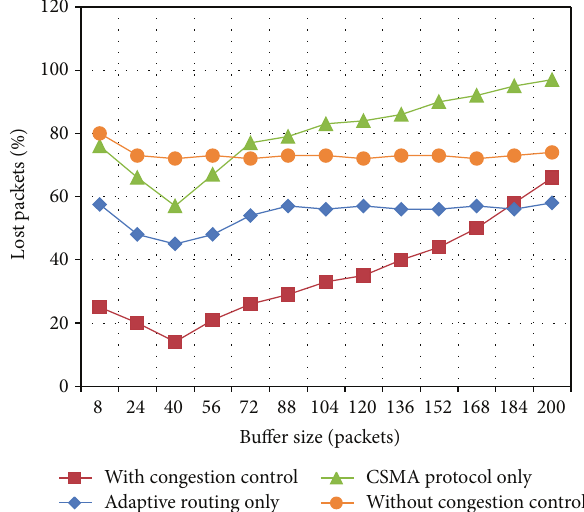
Figure 5: Lost packets versus buffer size for delay-sensitive applica- tions.